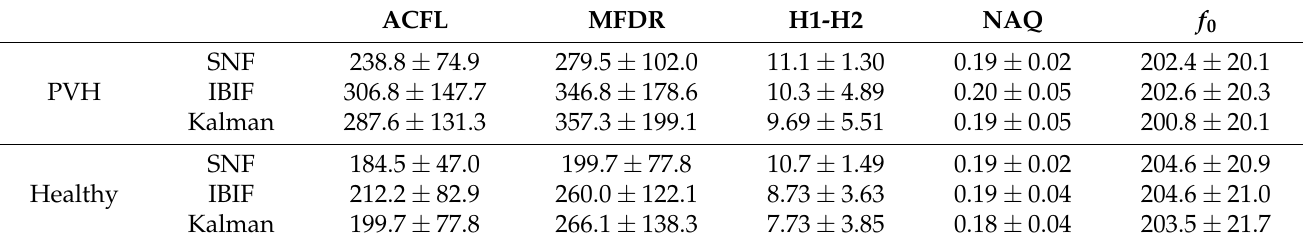
Table 2. Mean and ± standard deviation from a pool of average values of ACFL, MFDR, H1-H2, NAQ, and f 0 extracted from the Rainbow Passage (voiced frames only).